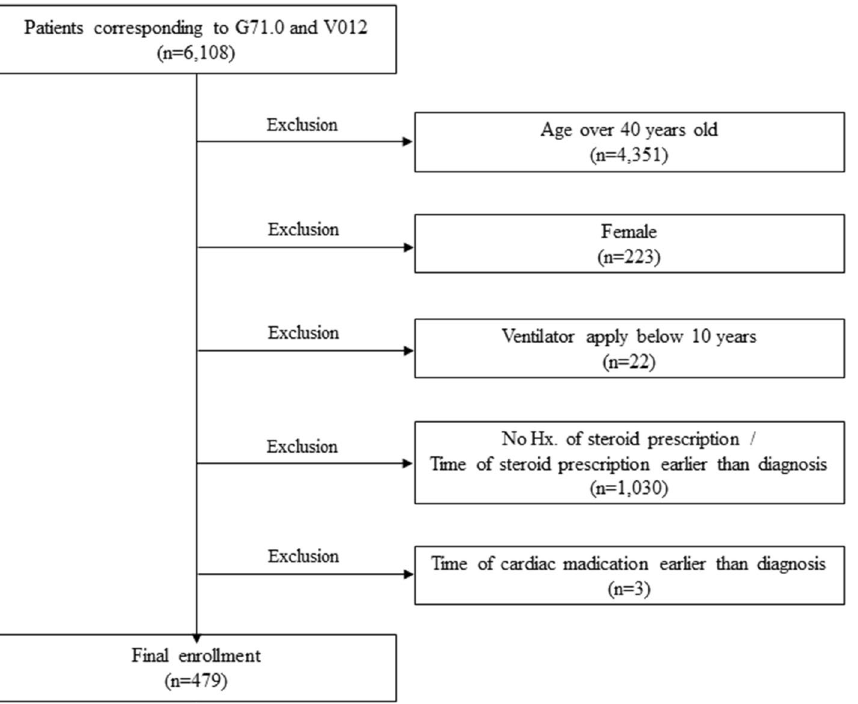
Figure 1. Flow diagram of patient inclusion and